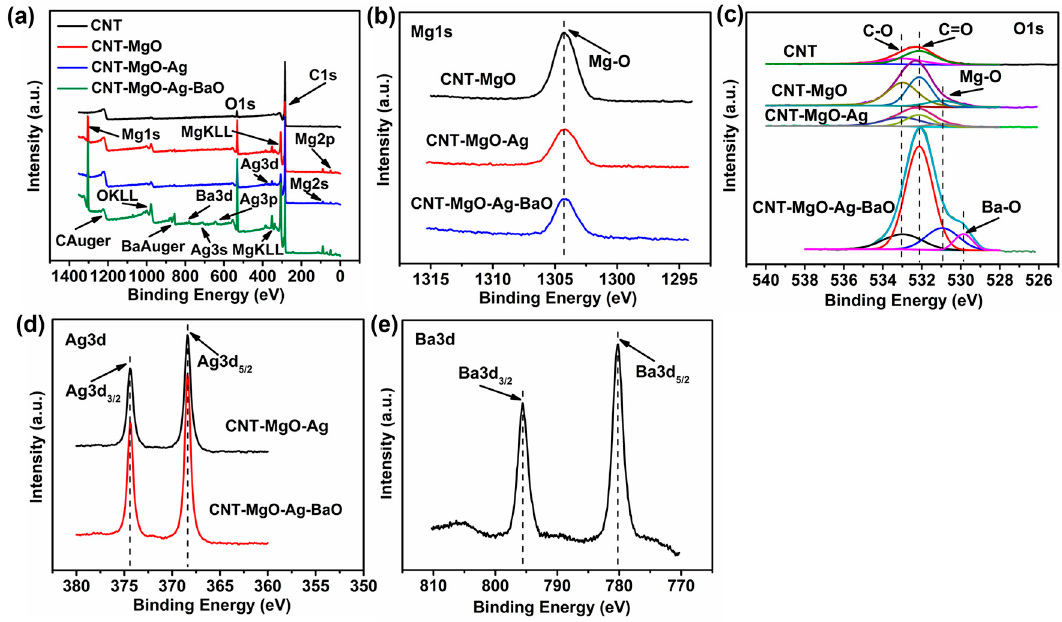
Figure 4 . XPS spectra of the CNT, CNT-MgO, CNT-MgO-Ag, and CNT-MgO-Ag-BaO composite Figure 4. XPS spectra of the CNT, CNT-MgO, CNT-MgO-Ag, and CNT-MgO-Ag-BaO composite samples. ( a ) Survey; ( b ) Mg1s; ( c ) O1s; ( d ) Ag3d; ( e ) Ba3d. samples. ( a ) Survey; ( b ) Mg1s; ( c ) O1s; ( d ) Ag3d; ( e )